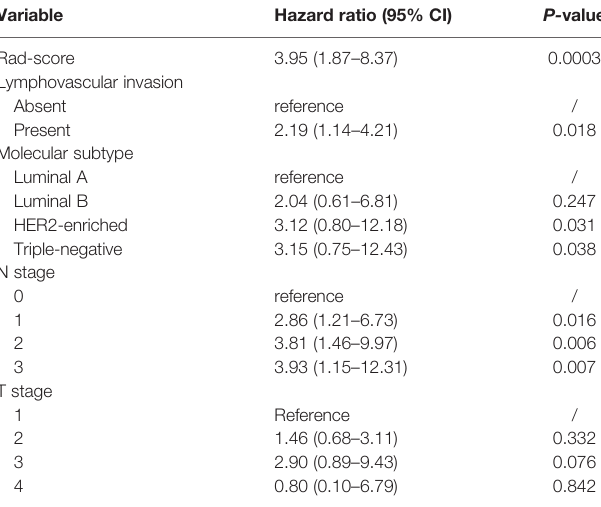
TABLE 3 | Multivariate analysis of DFS in the training